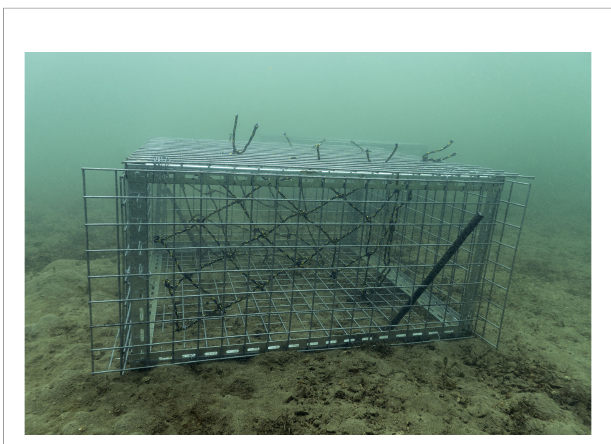
FIGURE 2 | Seahorse hotel containing dark blue net installed at Clifton